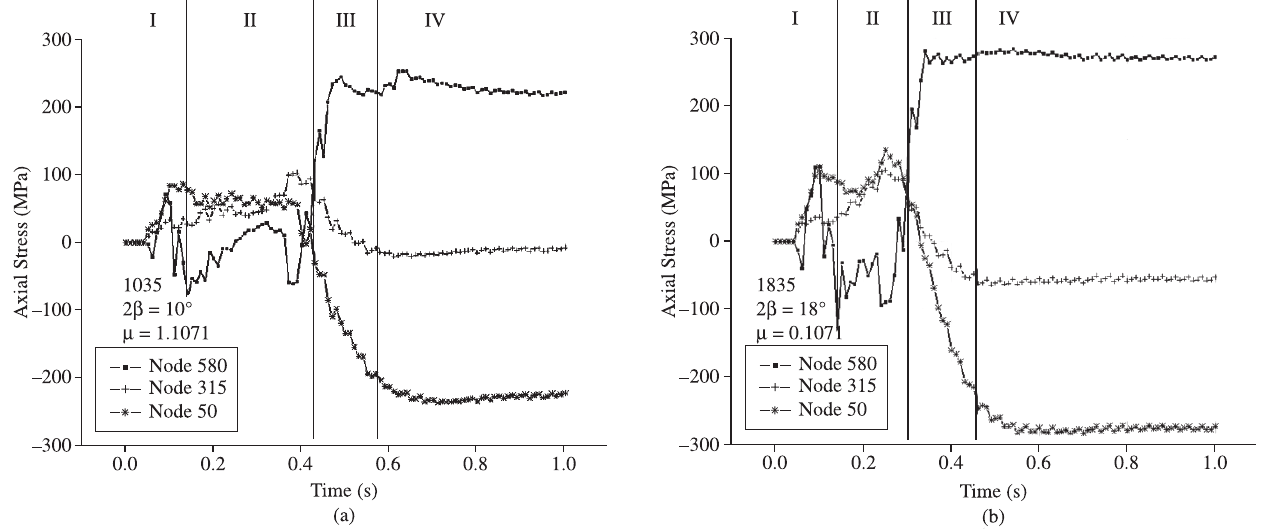
Figure 5. Axial Stress behavior during the wiredrawing process for a) 2 β = 10° and b) 2 β =